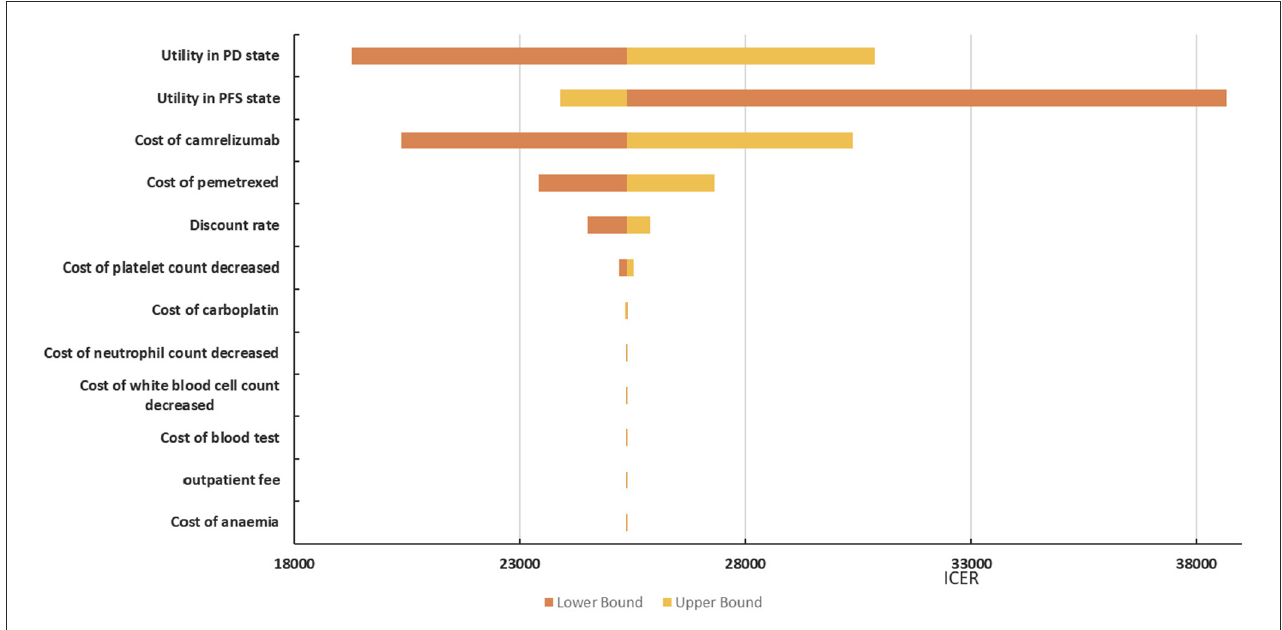
FIGURE4 Tornado diagram for ICER of camrelizumab + chemotherapy vs. chemotherapy.